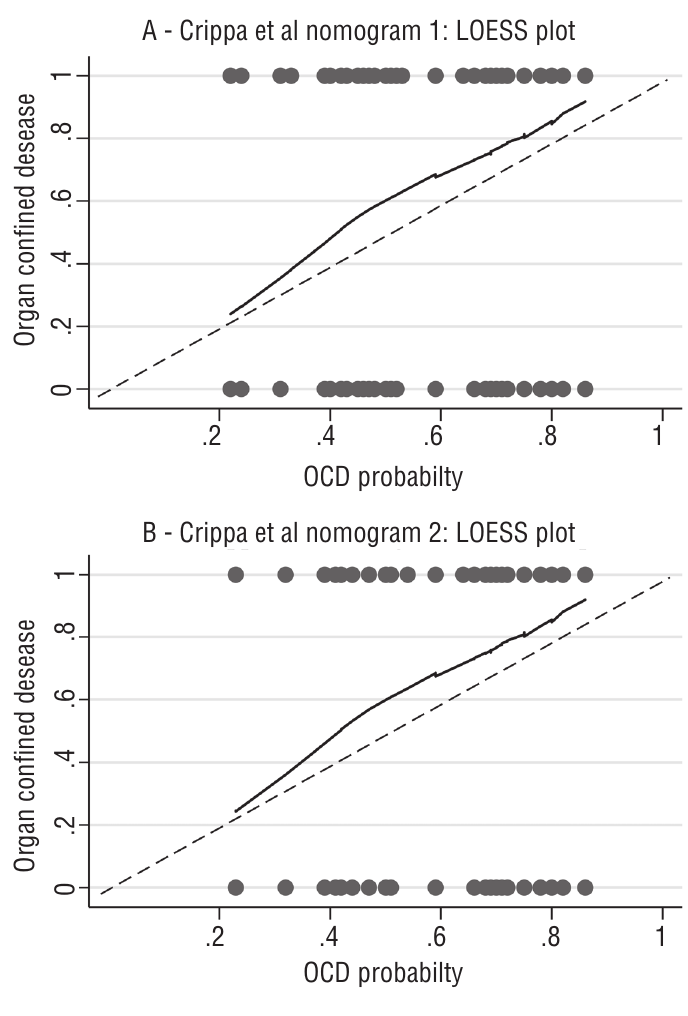
Figure 2 - LOESS plots for predictions based on both nomograms. Considerable overestimation of OCD in all ranges of prediction is